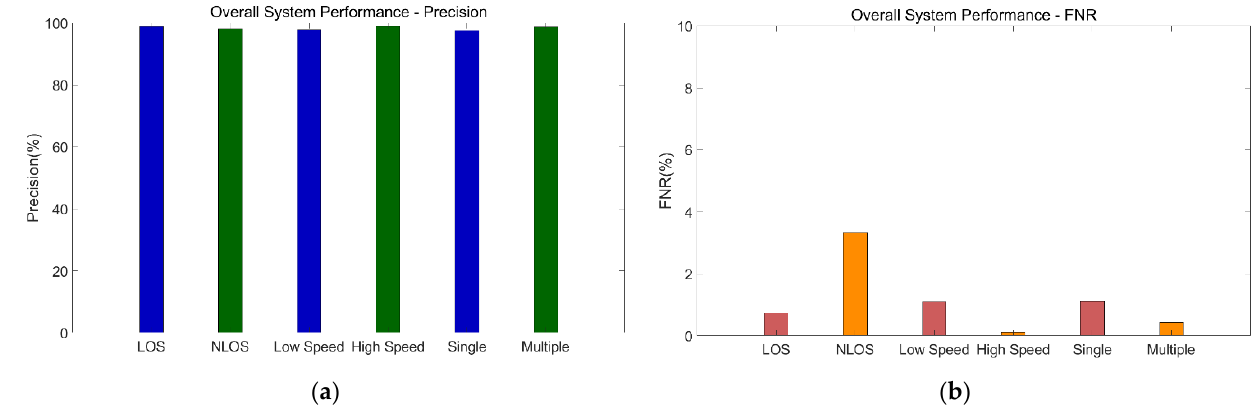
Figure 18. Overall system performance of precision and false negative rate (FNR). ( a ) Precision. ( b ) FNR.